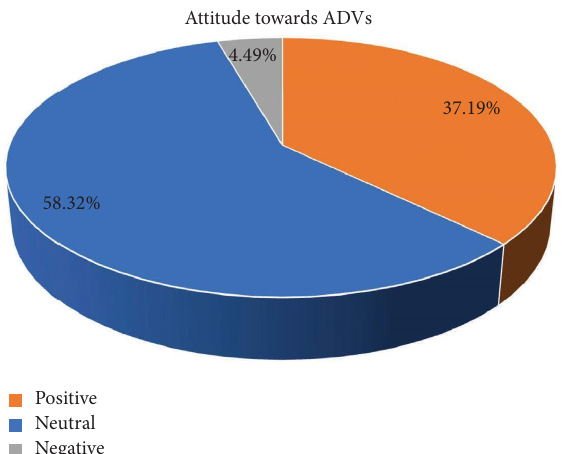
Figure 3: Percentage of respondents according to attitude towards ADVs.